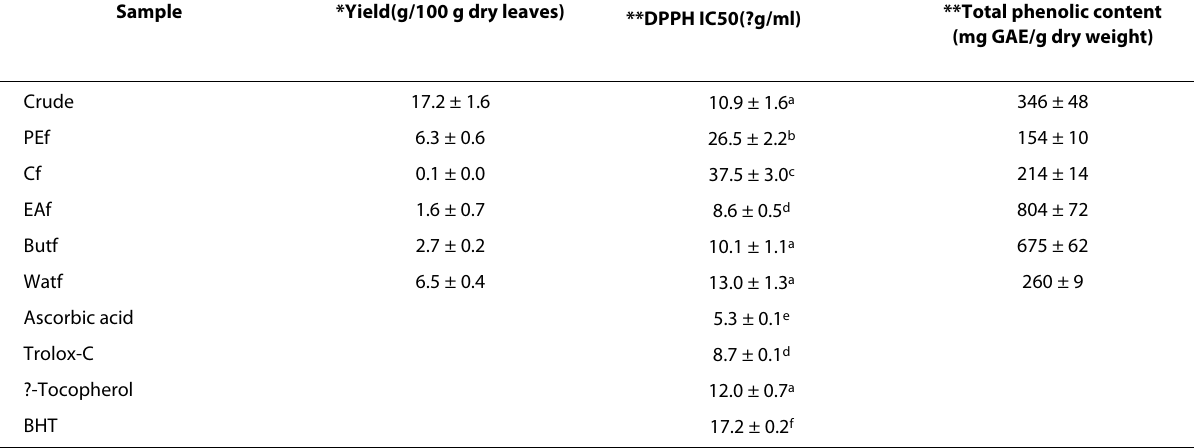
Table 1: Percentage yield, DPPH radical scavenging activity and total phenolic content of Blechnum orientale extracts